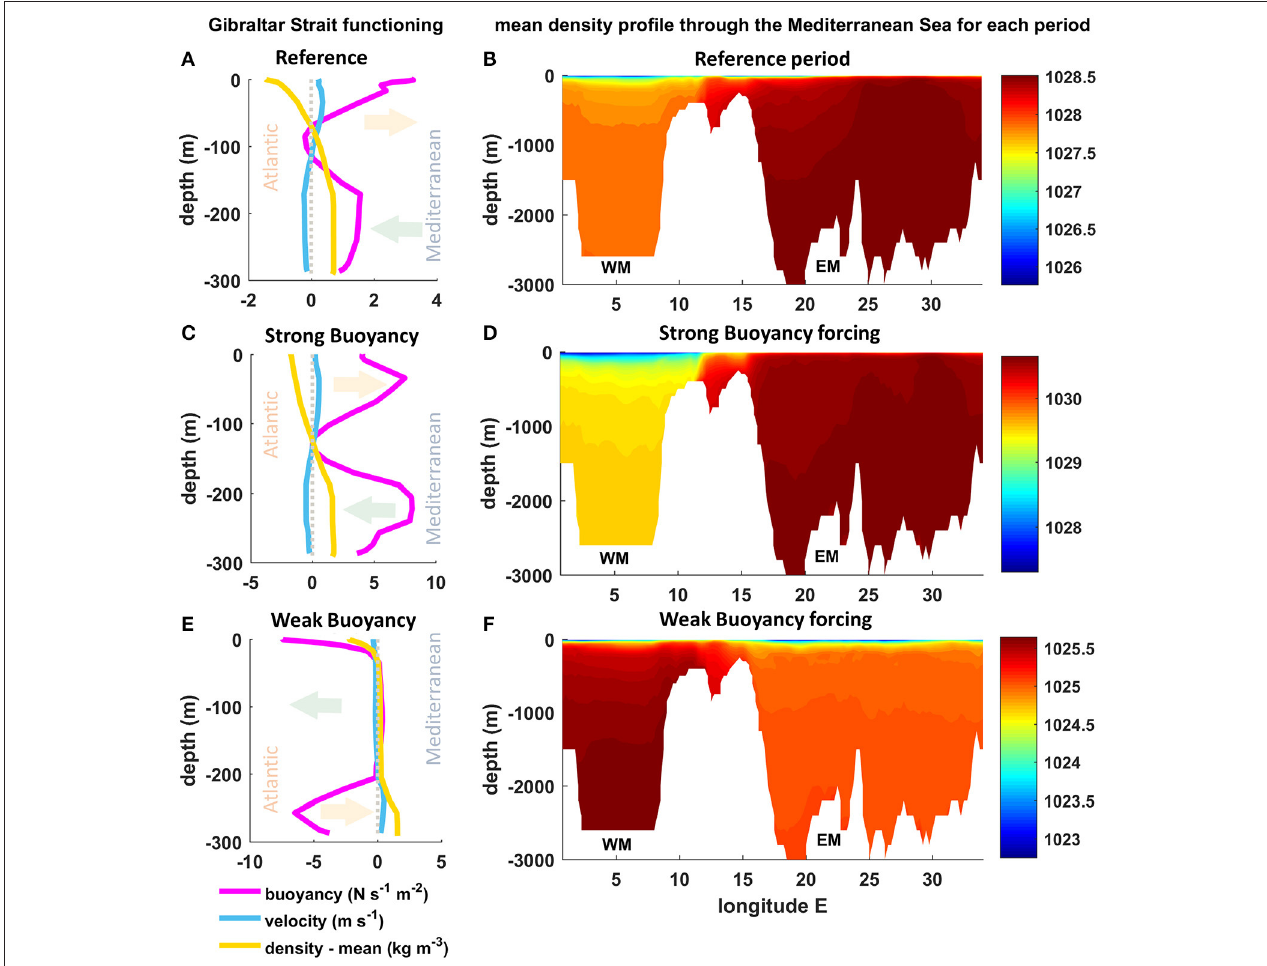
FIGURE 5 | Functioning of the Mediterranean Sea under the climate conditions of the three experiments: reference (top), SBF (middle), and WBF (lower panels). (A,C,E) reveal the overall functioning of the Mediterranean Sea as witnessed by the exchange at Gibraltar Strait. The pink arrow denotes the inflow of Atlantic water, whereas the light blue arrow corresponds to the outflow from the Mediterranean. The density distribution along the transect of Figure 2 along the Mediterranean is shown in (B,D,F) . In all figures, the values are annual means, averaged over the last 100 years run with the diagnosed fluxes for each